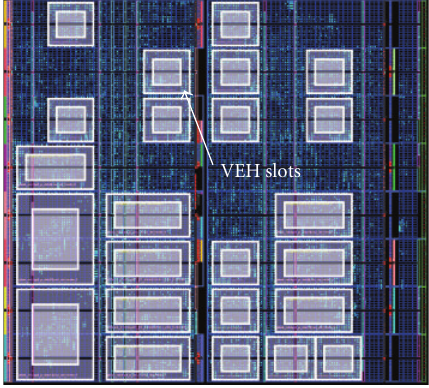
Figure 13: FPGA layout for 24 VEH slots.